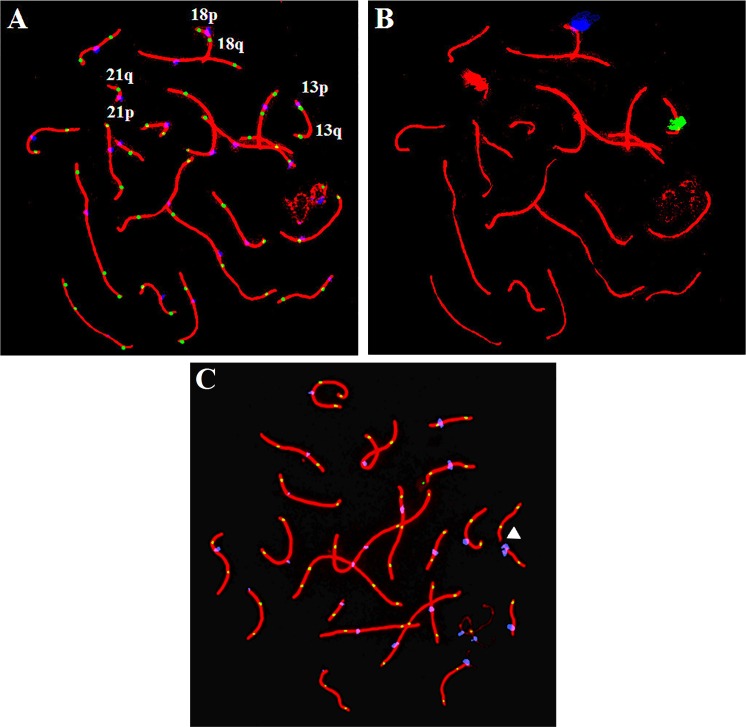
Immunofluorescence and FISH analysis of pachytene spermatocytes.(A) Spermatocytes were immunostained using antibodies against SYCP3/SYCP1, MLH1 and CREST to visualize the SC (red), crossover sites (green) and centromeres (blue). A spermatocyte with 45 crossovers from patient OA20 is shown. Although patient OA20 displayed normal rates of recombination, the crossover distribution on chromosome 18 was altered. We observed an increase in crossovers near the centromere and telomere on 18q and 18p, respectively. (B) Subsequent FISH was performed to identify chromosomes 13 (green, LSI 13), 18 (blue, CEP 18) and 21 (red, LSI 21) in the previously immunostained spermatocytes. (C) A spermatocyte from patient OA19 is shown. Although the patient showed normal rates of recombination, we observed an increased rate of synaptic errors compared to controls (Table 1). The unsynapsed region along a bivalent is indicated by the white arrow, where there is an absence of staining for SYCP3/SYCP1.